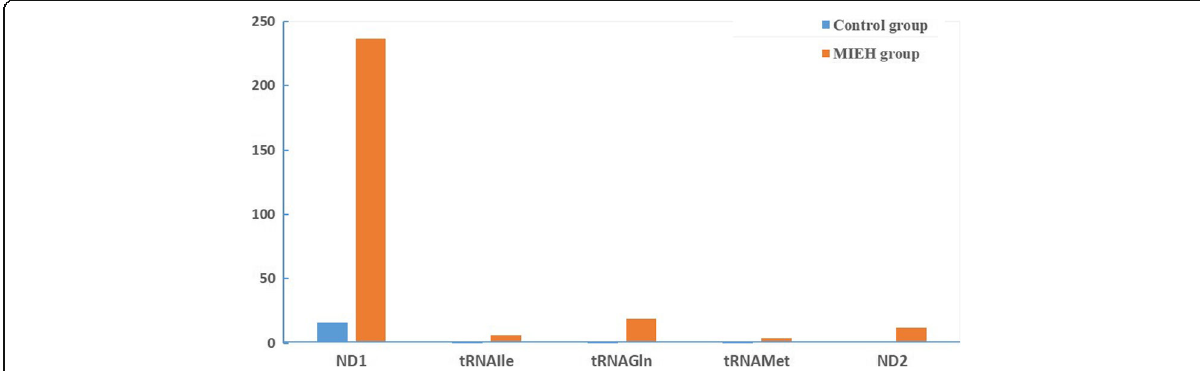
Fig. 1 Distribution histogram of the number of variants in mtDNA 3777 – 4679 bp among 5 genes